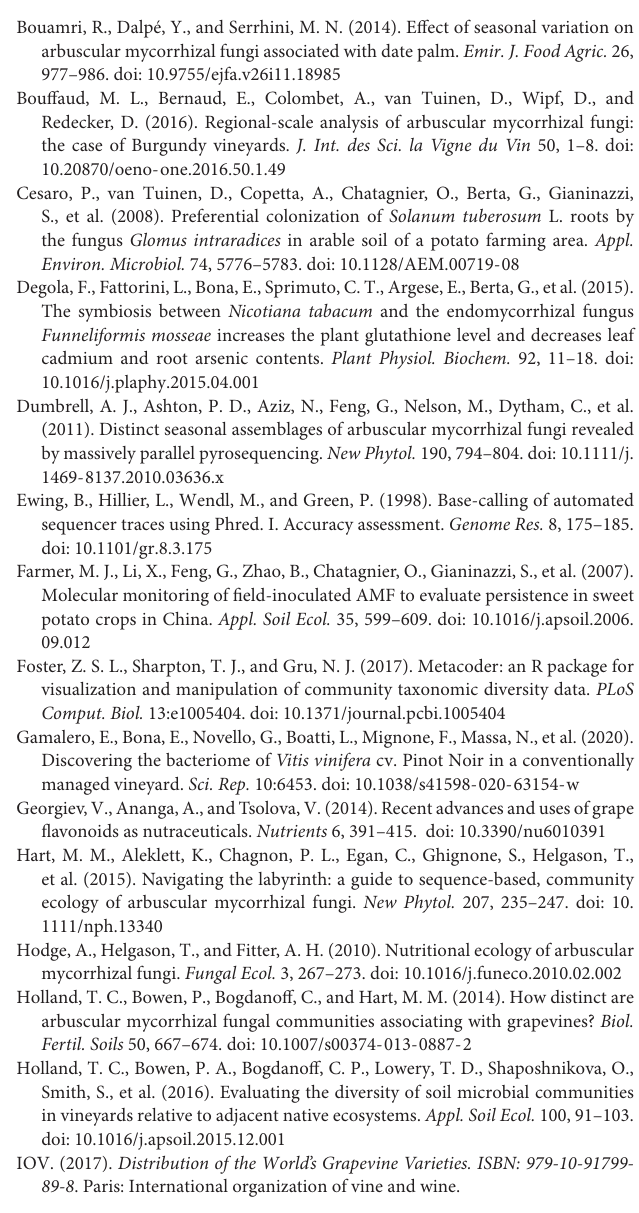
Supplementary Table 1 | List of IDs for “known” taxa identified by large subunit rDNA database. Supplementary Table 2 | Identification of de novo taxa by BLAST analysis against the NCBI database. Supplementary Table 3 | List of the IDs of “known” taxa (identified by large subunit rDNA database) and de novo taxa that were common between different soils (Bs or Rs) and in different sampling times (1S or 2S). Supplementary Table 4 | Heat tree difference table reporting the results ( p -values) of the non-parametric Wilcoxon rank–sum test used to depict the taxonomic differences between AMF